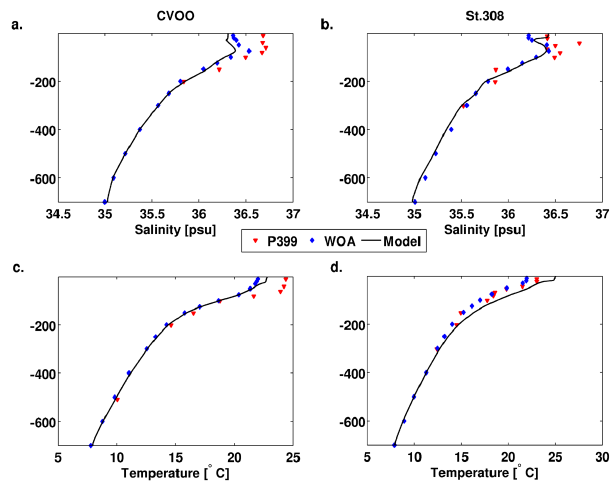
Fig. A1. Salinity [psu] (a, b) and temperature [ ◦ C] (c, d) profiles in April (a, c) and June (b, d) , model predictions (solid lines) and observations (red markers P399/2 cruise data, blue markers WOA data).